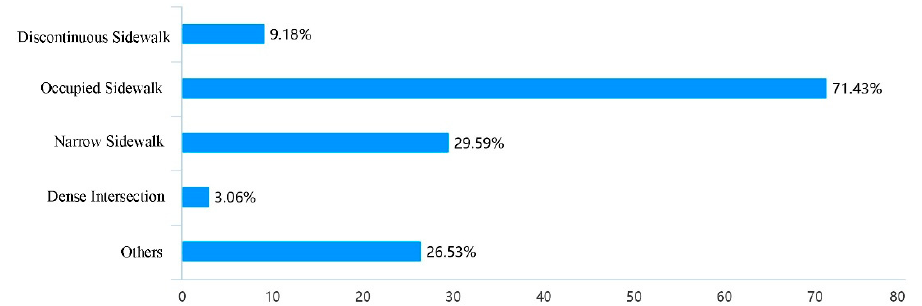
Figure 5. Factors causing pedestrian inaccessibility of the current school travel road.